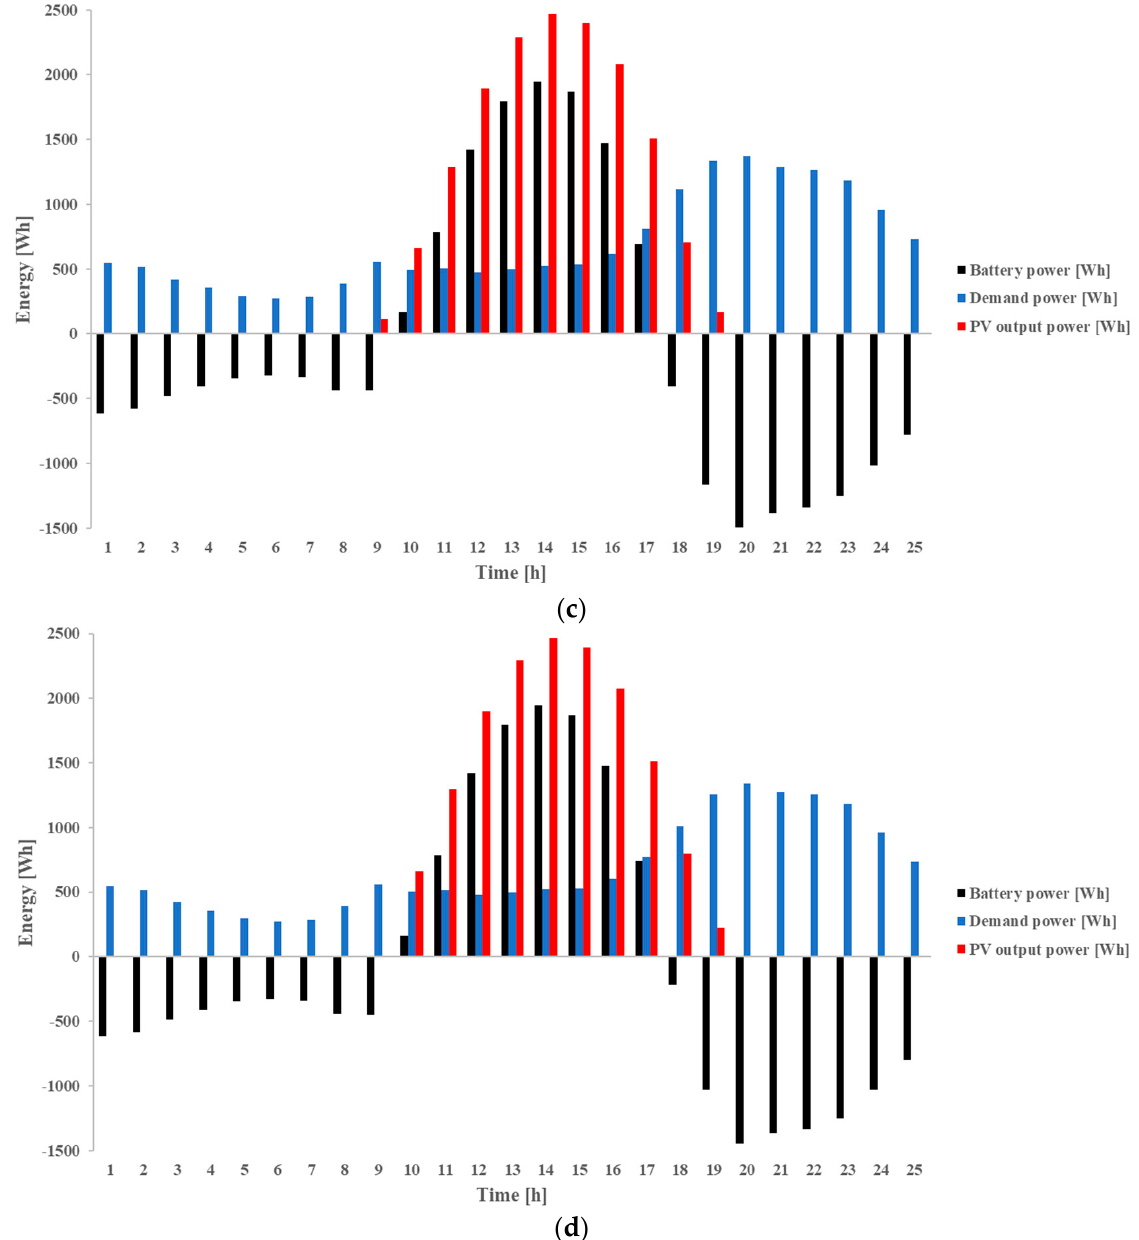
Figure 15. Proposed system hourly energy exchange for different components in ( a ) Base, ( b ) EV-2P, ( c ) EV-3P and ( d ) EV-4P scenarios.